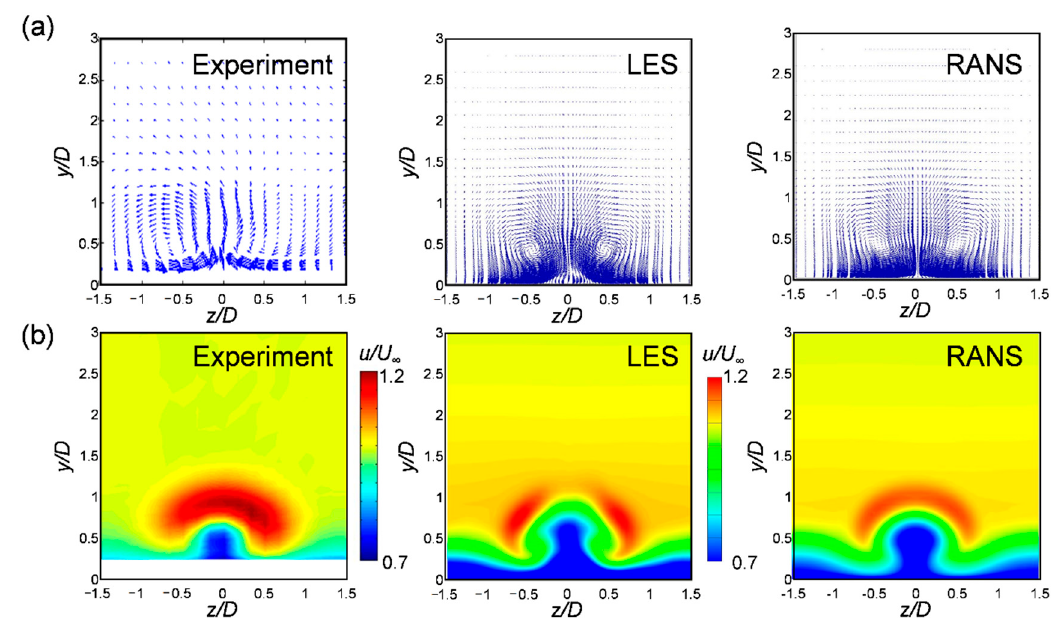
Figure 3. Time-averaged flow field at x / D = 2.5 for the streamwise film cooling when M = 1.0, compared with data from Burd et al. [35]: ( a ) Cross-stream velocity vectors and ( b ) streamwise velocity contour.